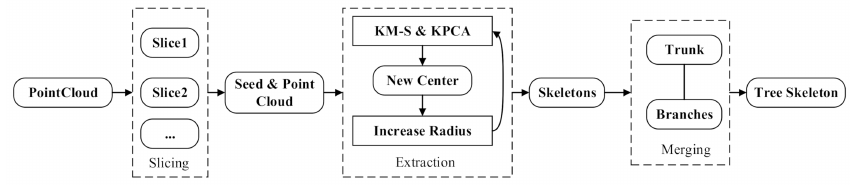
Figure 5. Flowchart of skeleton extraction and merging.